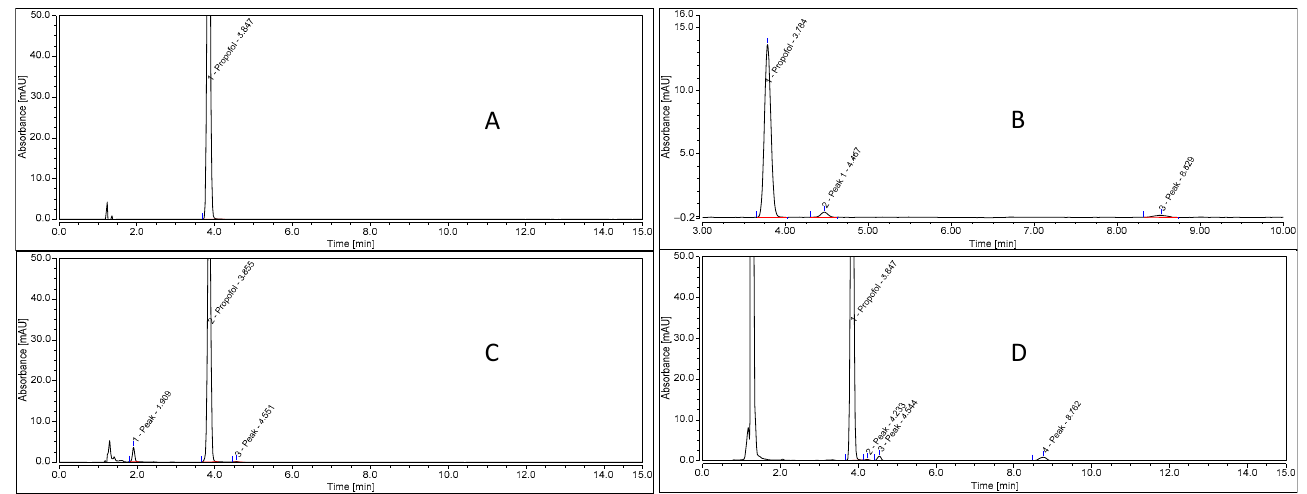
Figure 4. Chromatograms of propofol before degradation under stress conditions (( A ), Pharma Chemicals reference; ( B ), Sigma reference) and after degradation under stress conditions (( C ), Pharma Chemicals reference with NaOH degradation; ( D ), Pharma Chemicals reference with H 2 O 2 degradation).